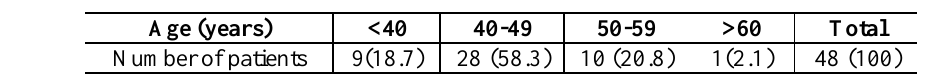
Table I : Age distribution of the patients